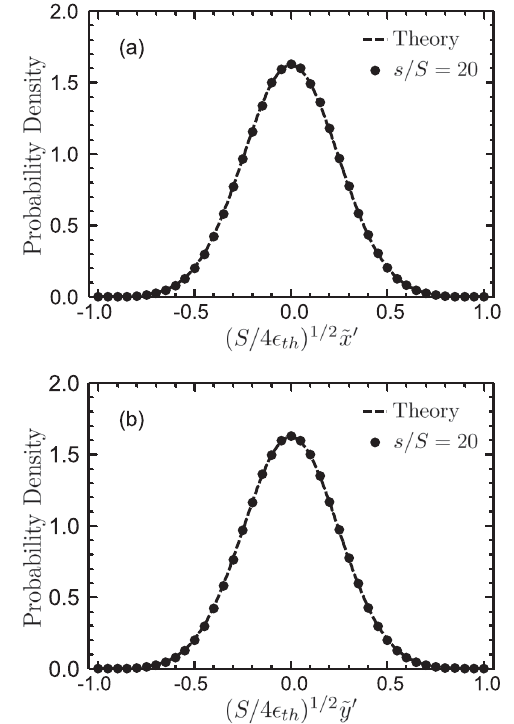
FIG. 2. Plots of the probability density distributions (cid:10) ð ~ x 0 Þ versus ð S= 4 " th Þ 1 = 2 ~ x 0 and the probability density distributions Þ 1 = 2 ~ y 0 at s=S ¼ 20 . The dotted curves are (cid:10) ð ~ y 0 Þ versus ð S= 4 " th from the simulation, whereas the dashed curves are from the theoretical predictions.